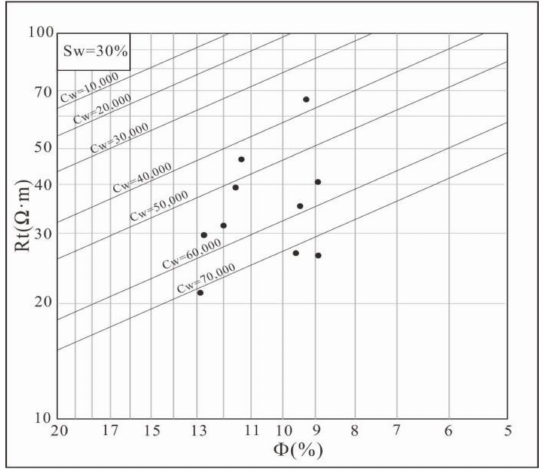
Figure 7. Modified resistivity–porosity base plate under variable salinity conditions ( S w = 30%).